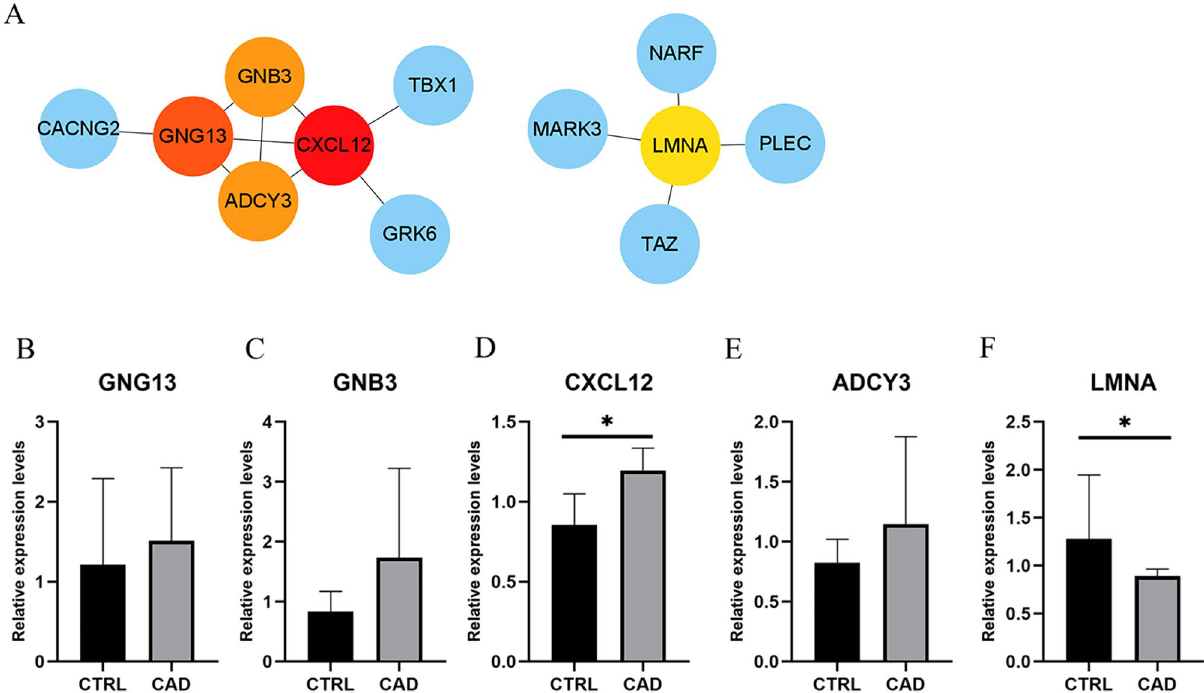
Figure 5. Analysis of PPI network and verification of top 5 key mRNAs in LINC00968-related ceRNA network. ( A ) The edges represented protein–protein associations which were meant to be specific and significant, the colored nodes (red and orange) represented top 5 key mRNAs identified by CytoHubba in Cytoscape. ( B – F ) qRT-PCR verification of top 5 key mRNAs in LINC00968 related ceRNA network. CXCL12 expression levels were significantly increased in EAT of CAD. Controversially, LMNA expression level was decreased in EAT of CAD. * p < 0.05. In each column, error bars show the mean and standard deviation per